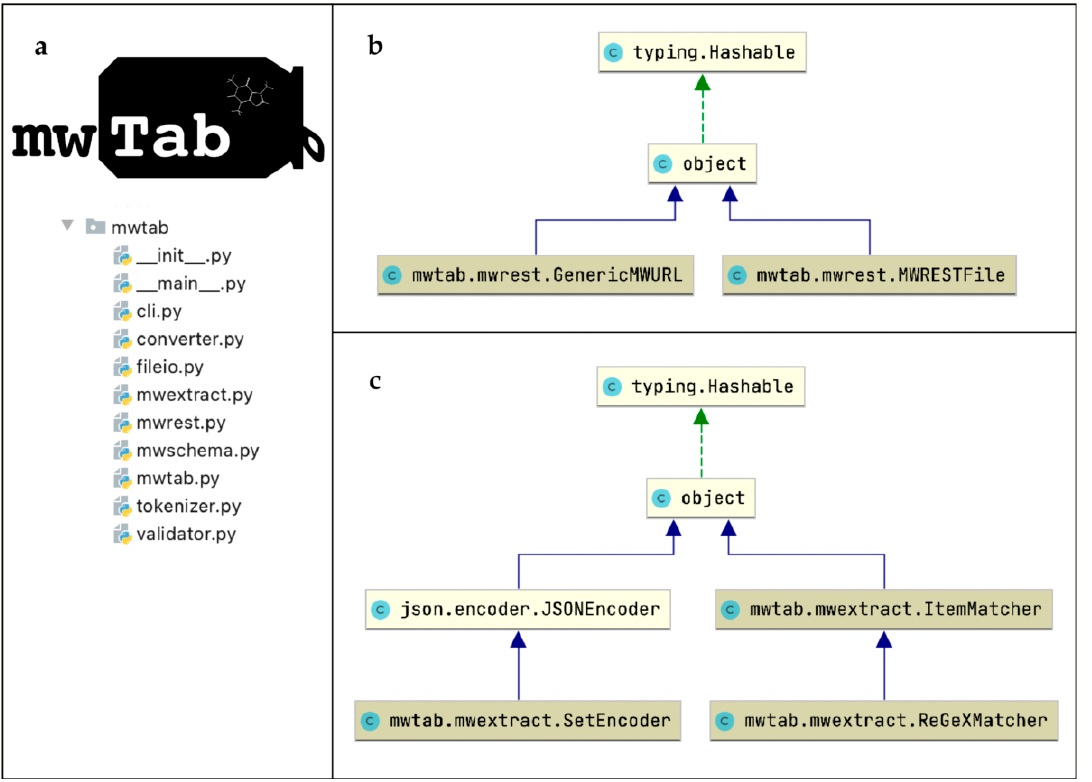
Figure 7. Organization of the ‘mwtab’ Python package represented with Unified Modeling Language (UML) diagrams: ( a ) UML package diagram of the ‘mwtab’ Python library; ( b ) UML class diagram of the ‘fileio.py’ module; ( c ) UML class diagram of the ‘mwtab.py’ module; d. UML class diagram of the ‘converter.py’ module.